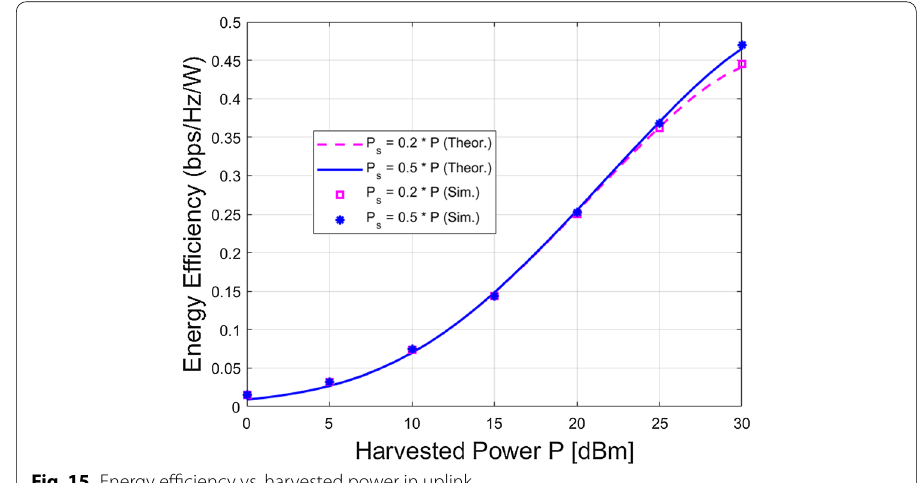
Fig. 15 Energy efficiency vs. harvested power in uplink